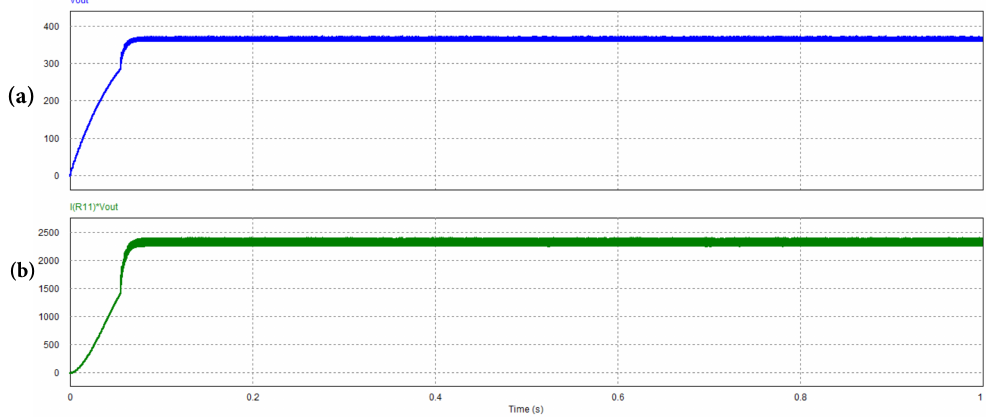
Figure 16. Sixth set of simulation results, ( a ) primary DC bus and ( b ) power harvested from PV array. A sequence from 0% to 100% PV array rating power shows: in Figure 16a boost converter output voltage to set primary bus, mainly voltage value keeps around 380 V but, voltage ripple performing in this mode is larger than in regulation mode deu to. In Figure 16b waveform of power taaken form PV array in time domain.